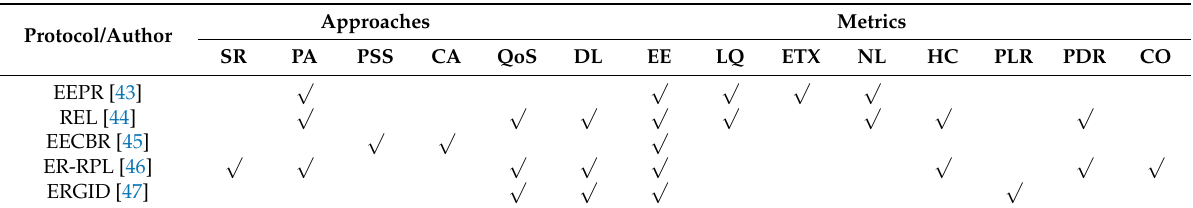
Table 11. Comparative assessment of energy efficient routing